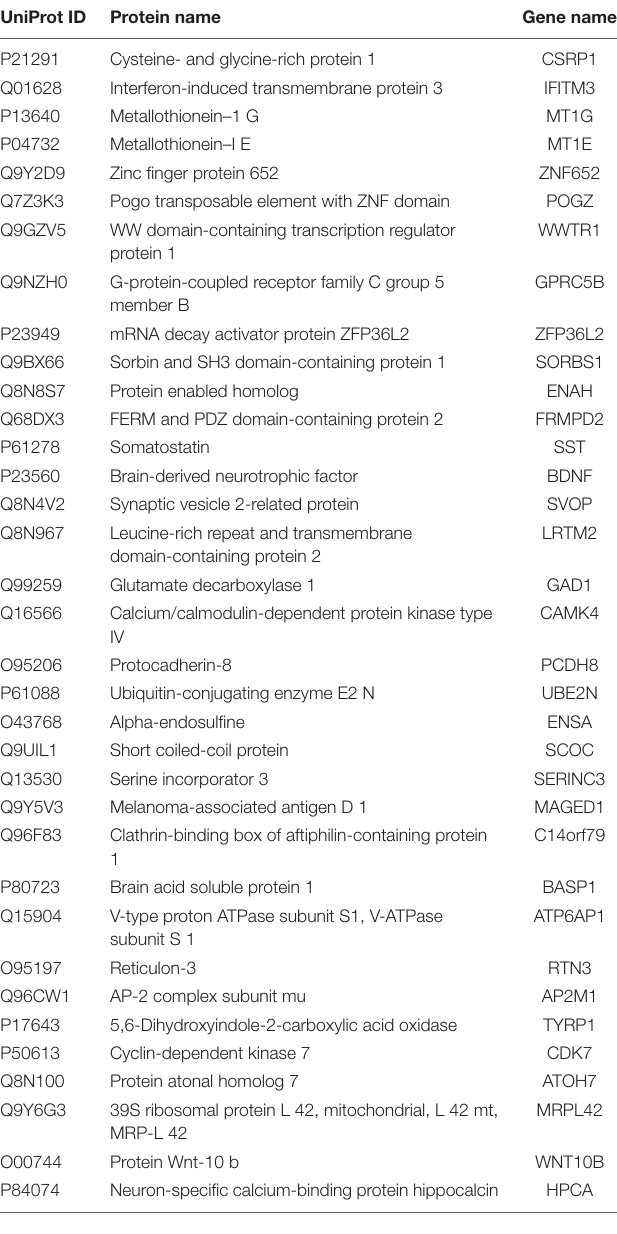
TABLE 2 | The list of 35 potential biomarkers of AD using LASSO logistic